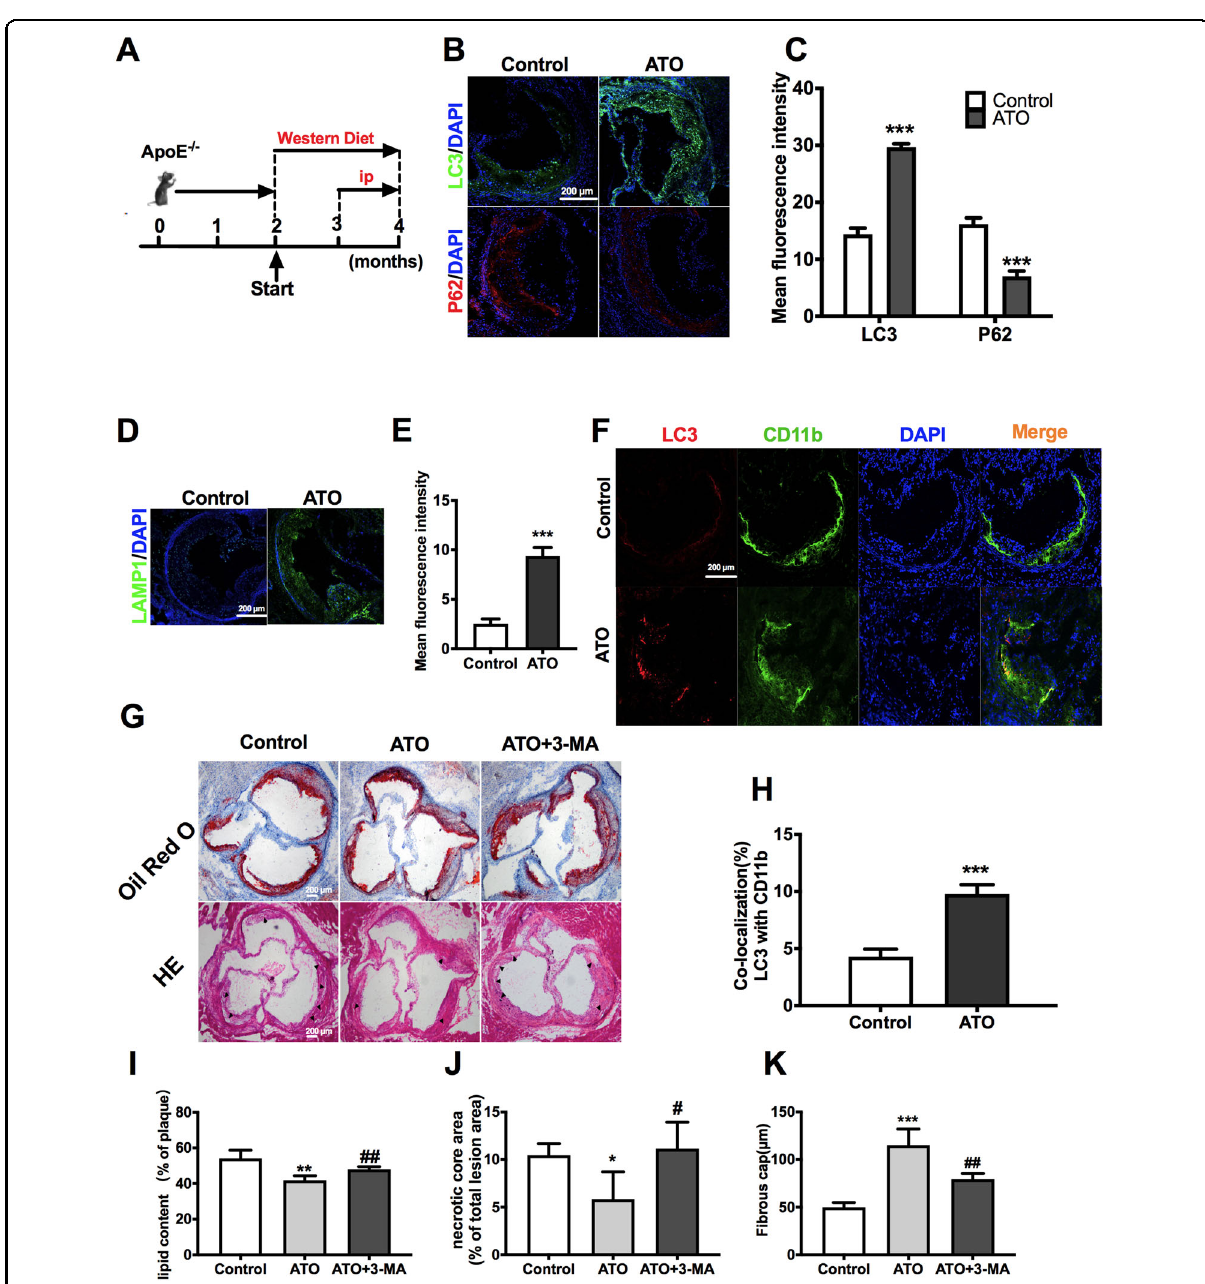
Fig. 7 ATO administration accelerates autophagy in the aorta of ApoE − / − mice and reduces atherosclerotic lesion. A ApoE − / − mice were fed a western diet and were treated intraperitoneally with ATO (2.5 mg/kg) or the same volume of vehicle in saline as described in methods to establish early-stage atherogenesis lesions. B , C IF images of early-stage atherosclerotic (ApoE-KO) aortic roots stained with antibodies against LC3 (green), p62 (red) and DAPI (blue). Scale bars = 200 μ m ( n = 3 mice per group). D , E Representative immuno fl uorescence images of atherosclerotic aortic roots stained with antibodies against LAMP1 (green) and DAPI (blue). Scale bars = 200 μ m ( n = 3 mice per group). F , H Co-localization of LC3 (red) and CD11b (green) was also analyzed in the same aortic roots, and DAPI (blue) was added to label nuclei. Scale bars = 100 μ m. G Representative Oil Red O and H&E staining of cross sections of aortic roots in the control, ATO, and ATO + 3-MA groups ( n = 4 mice per group). The arrow indicates necrotic core. Scale bars = 200 μ m. I The lipid content was calculated and analyzed from Oil Red O staining images. J , K The nerotic core area and thickness of fi brous cap were calculated and analyzed from H&E staining images. Data are expressed as mean ± SD from 3 independent experiments. * p vs. Control, # p vs. ATO. * p < 0.05, ** p < 0.01, *** p < 0.001, # p < 0.05, ## p < 0.01, and ns means non-signi fi